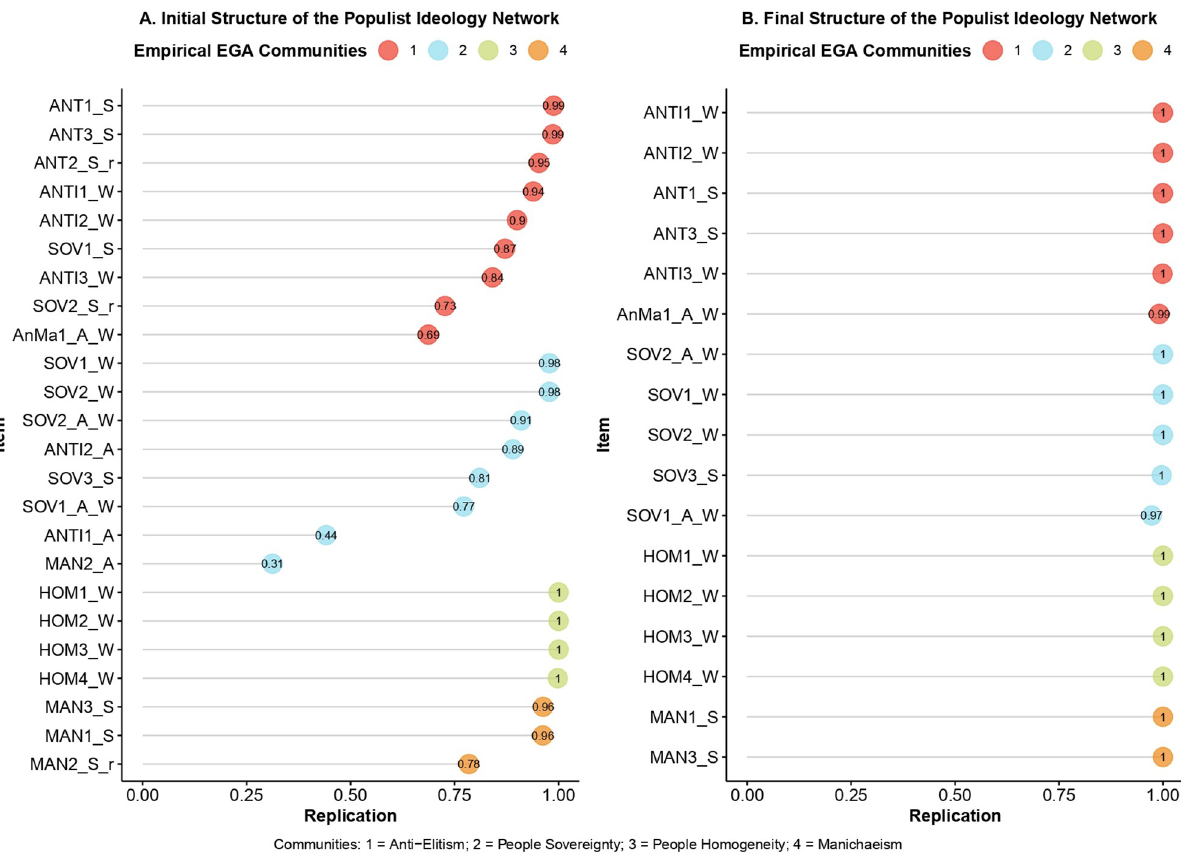
Fig 2. Items’ stability across the initial and final structure of populist ideology network. (A) Items’ stability results from the EGA model of the initial solution of populist ideology network structure. (B) Items’ stability results from the EGA model of the final solution of populist ideology